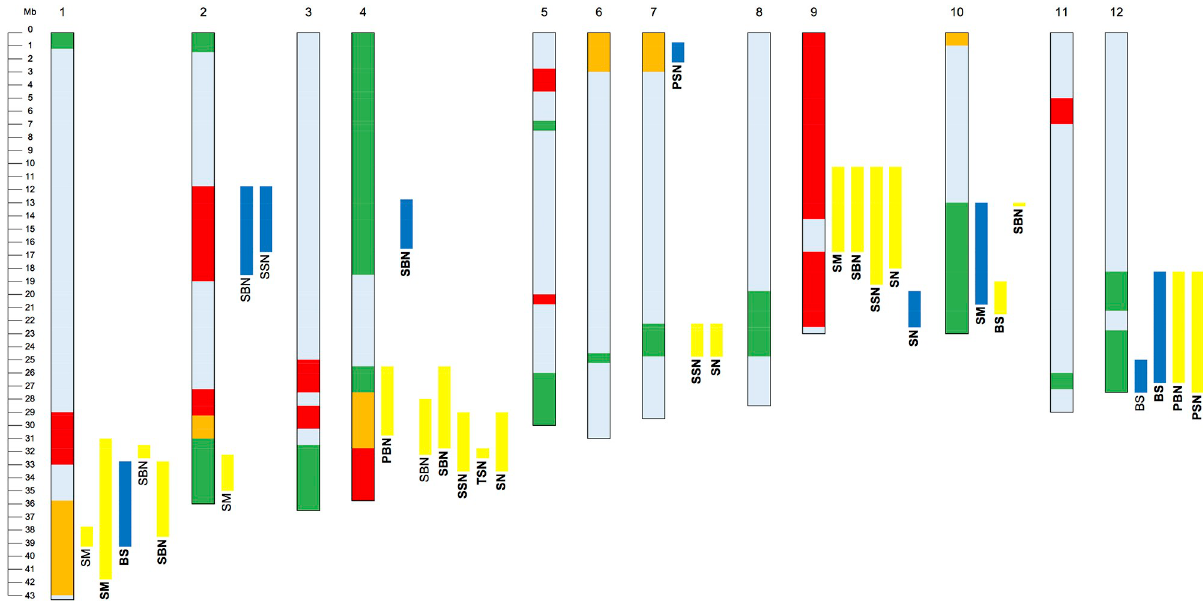
Fig 4. Haplotype of Monster Rice 1 and QTL positions. Green bar on chromosome, haplotype of Leaf Star; red bar on chromosome, haplotype of Akenohoshi; yellow bar on chromosome, same haplotype between Leaf Star and Akenohoshi; light blue bar on chromosome, Takanari haplotype. Yellow bar to the right of chromosome signifies a QTL for which Monster Rice 1 allele had a positive effect; blue bar to the right of chromosome signifies a QTL for which Takanari allele had a positive effect. Normal letters signify a QTL detected in F 2 ; bold letters signify a QTL detected in